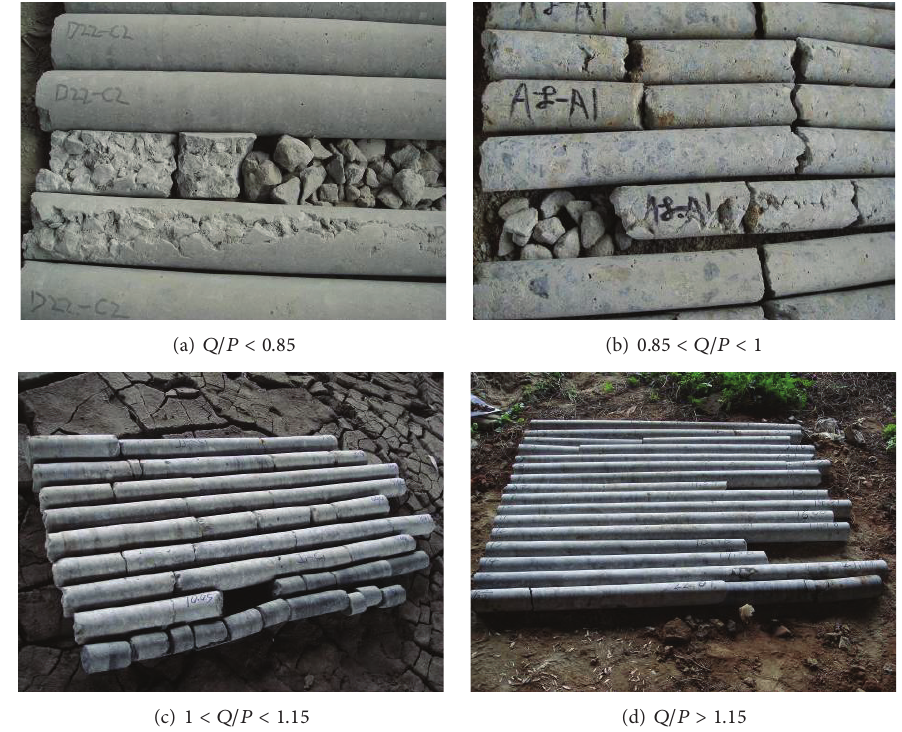
Figure 13: Pictures of typical core drilling